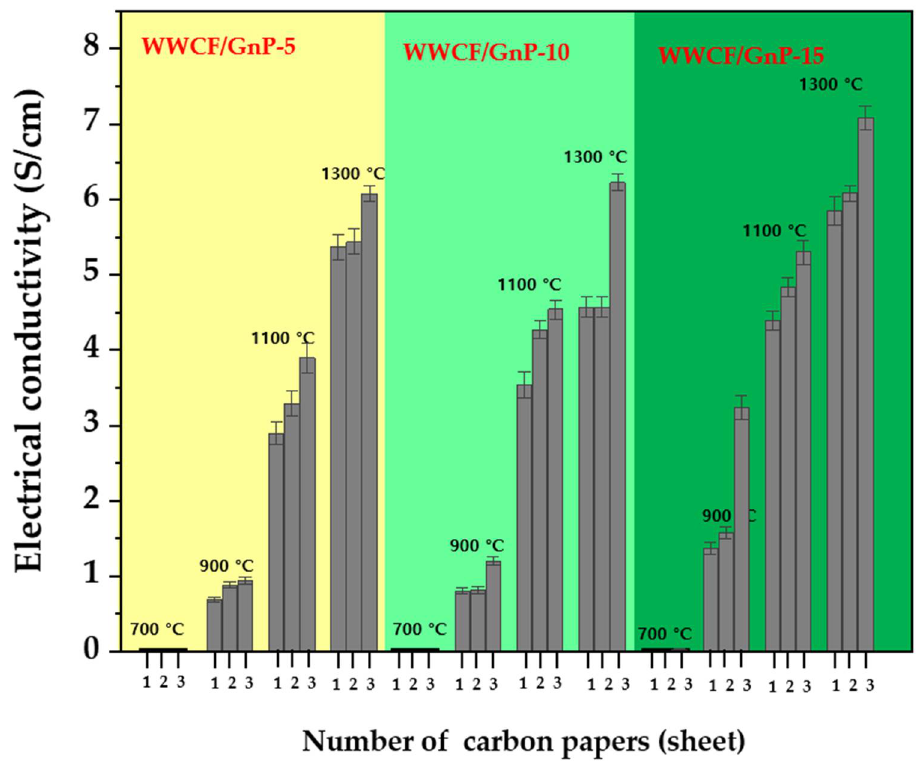
Figure 5. The electrical conductivity comparison of waste wood cellulose fiber/graphene nanoplatelet (WWCF/GnP) carbon papers prepared according to the GnP content, carbonization temperature, and number of overlapped carbon paper sheets.